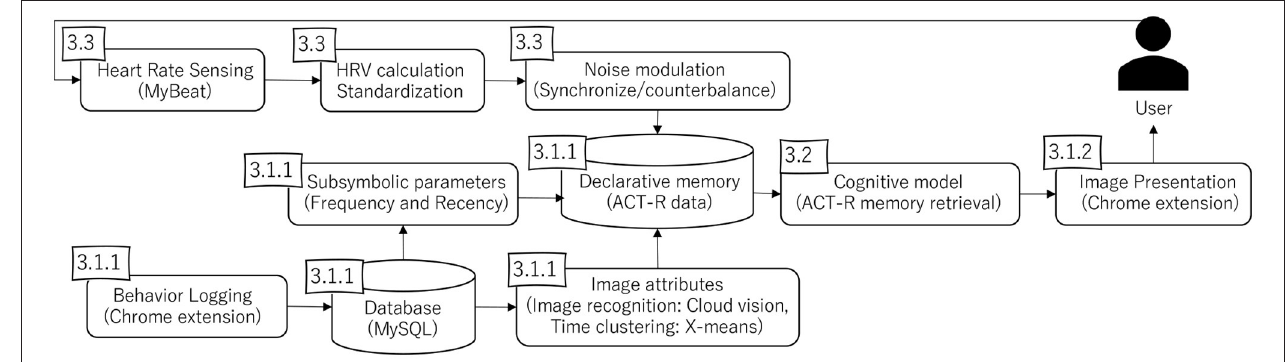
FIGURE 1 | System overview. The numbers in the boxes indicate the sections describing each component. The data stored by the behavior logging (3.1.1) is transformed into data compatible with the ACT-R cognitive model (3.2), which outputs sequential image presentations (3.1.2). The user’s reaction is monitored by heart rate sensing (3.3), to make the model synchronize or counterbalance with the user’s